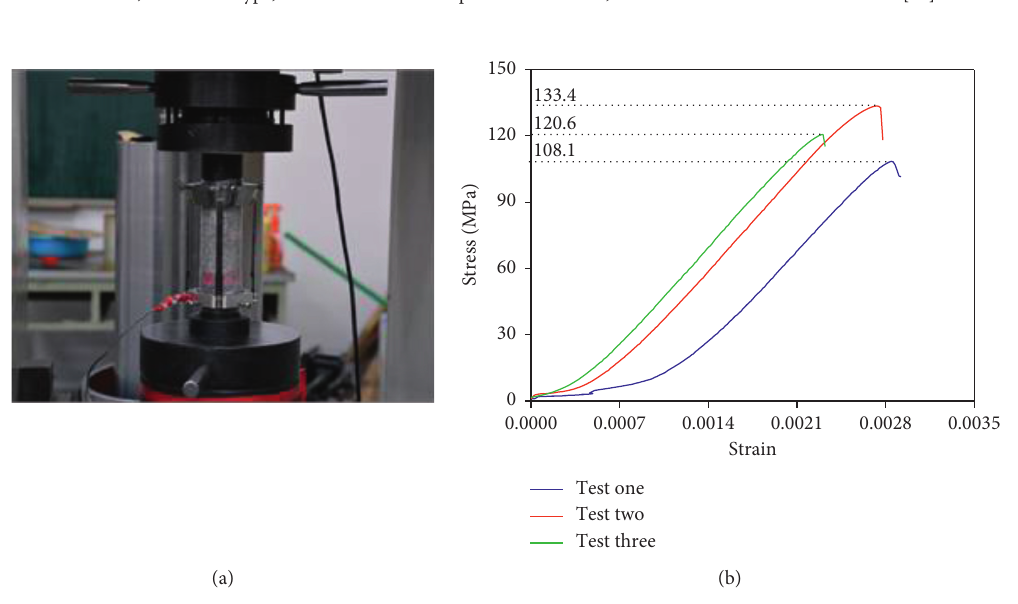
Figure 5: Rock compression test: (a) uniaxial compressive test and (b) the strain-stress curve.